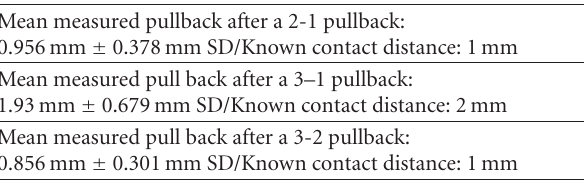
Figure 5: Pullback amount at the 3-1 condition in size-ordered temporal